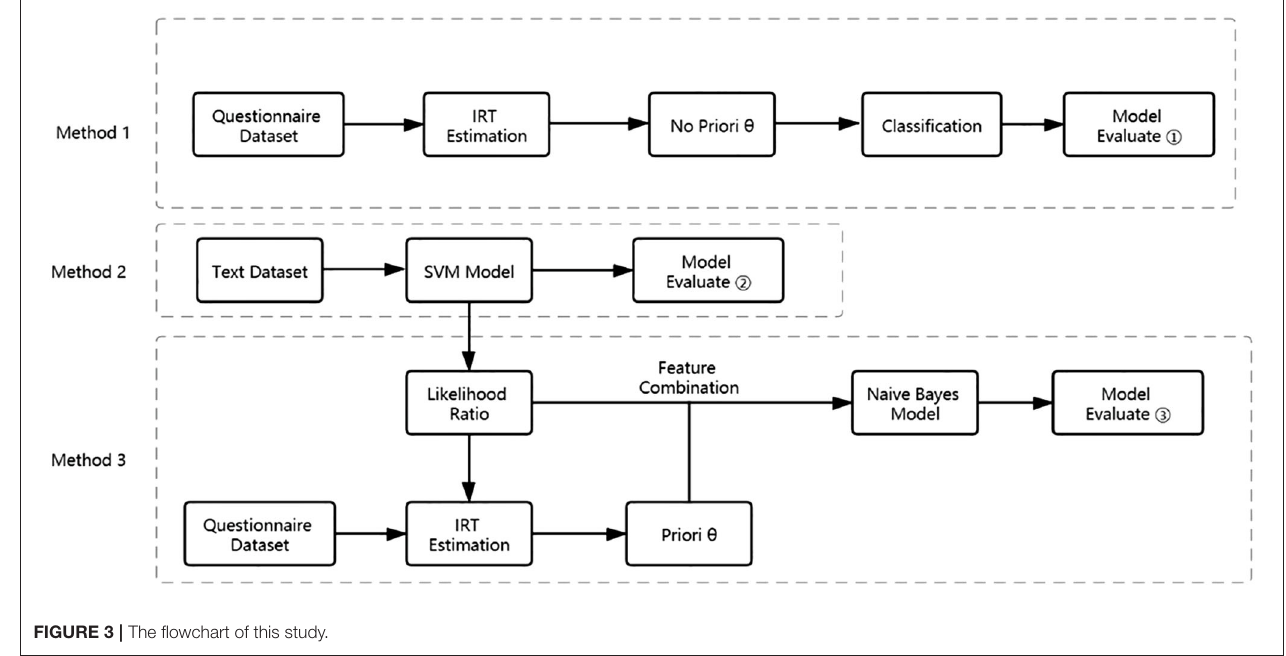
FIGURE 3 | The flowchart of this